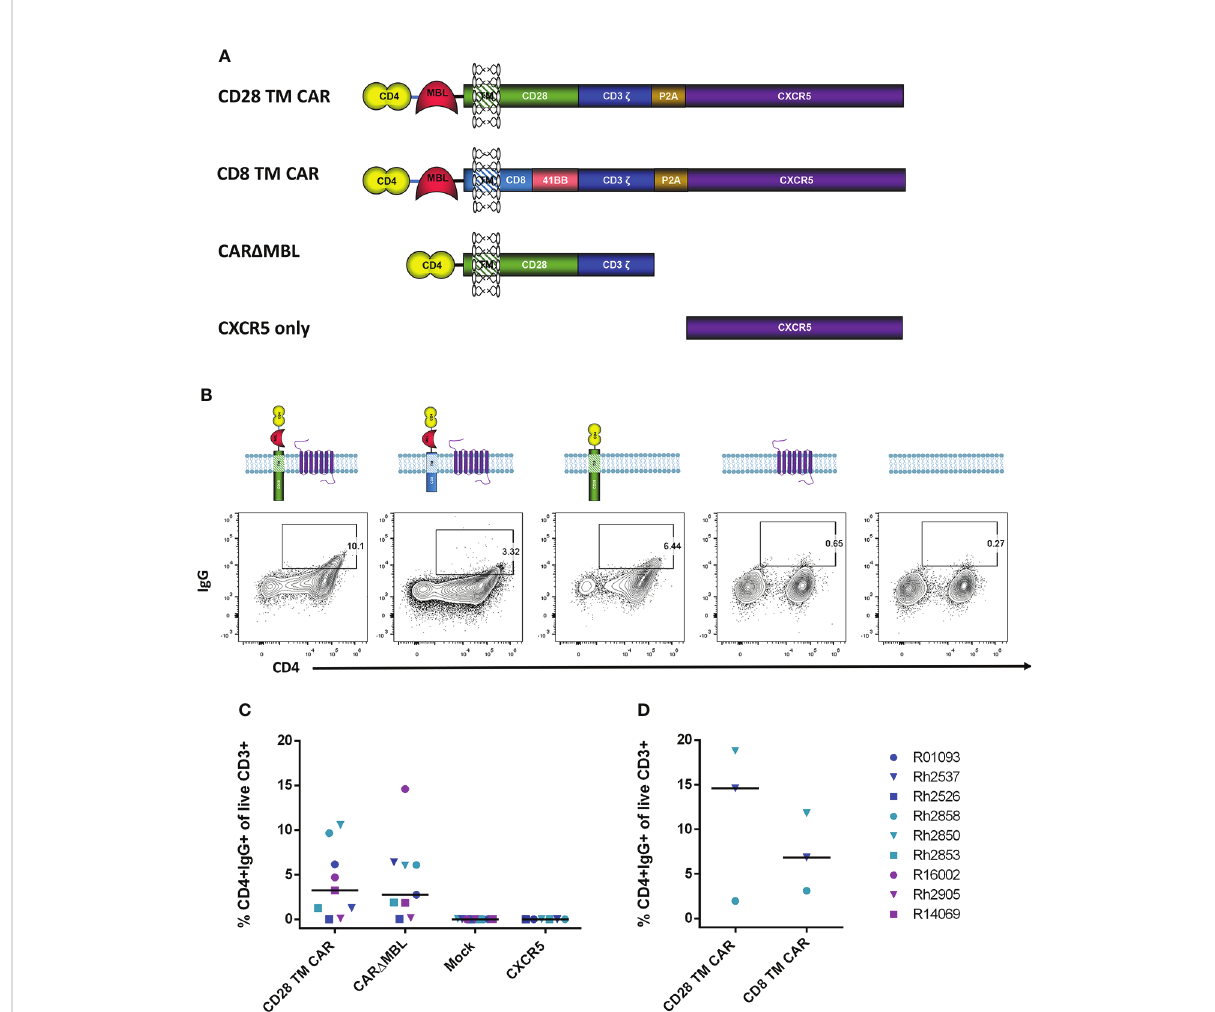
FIGURE 2 Serum IgG antibodies from treated animals bind CAR-expressing cells. (A) Schematic drawings of each construct. The original CD4-MBL CAR/ CXCR5 (labeled CD28 TM CAR), a CD4-MBL CAR with a CD8 transmembrane domain (CD8 TM CAR), A CAR with CD4 D1/D2 and CD28 transmembrane domain (CAR D MBL) and CXCR5 only. P2A functions as a self-cleaving peptide to cleave the nascent CAR and CXCR5 polyprotein. CXCR5 encodes the endogenous rhesus CXCR5 protein. (B) Serum from animals was incubated with cells transduced with the indicated constructs and their expression at the cell surface. Representative fl ow cytometry plots showing the percent of CD4+IgG+ cells. Cells were gated on live CD3+ lymphocytes. (C) The percent of CD4+IgG+ cells in cells transduced with CD28 TM CAR (n=9), CAR D MBL (n=9), mock (n = 9), and CXCR5 only (n = 6) in treated animal serum from 28 to 83 DPT. Bars are drawn at the median. (D) The percent of CD4+IgG+ cells of cells transduced with the CD28 TM CAR (n = 3) and CD8 TM CAR (n=3) in treated animal serum from 70 to 168 DPT. Data is presented for T1 (blue), T2 (teal), T3 (purple) and control (red)